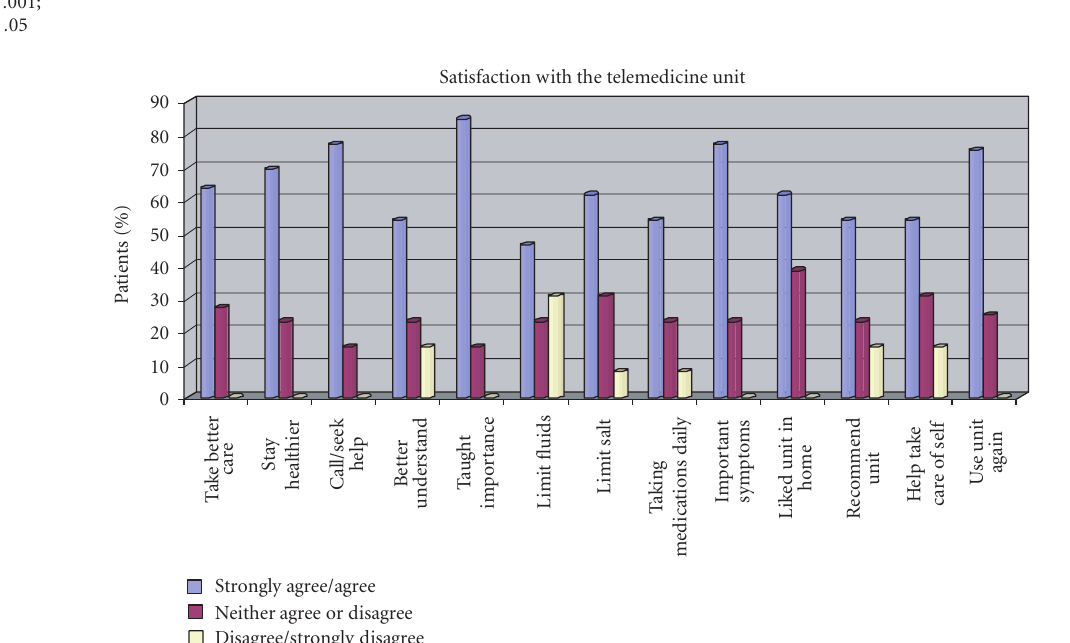
Figure 2: Percent of patients’ overall satisfaction with the telemedicine unit and satisfaction in the unit’s assistance in managing